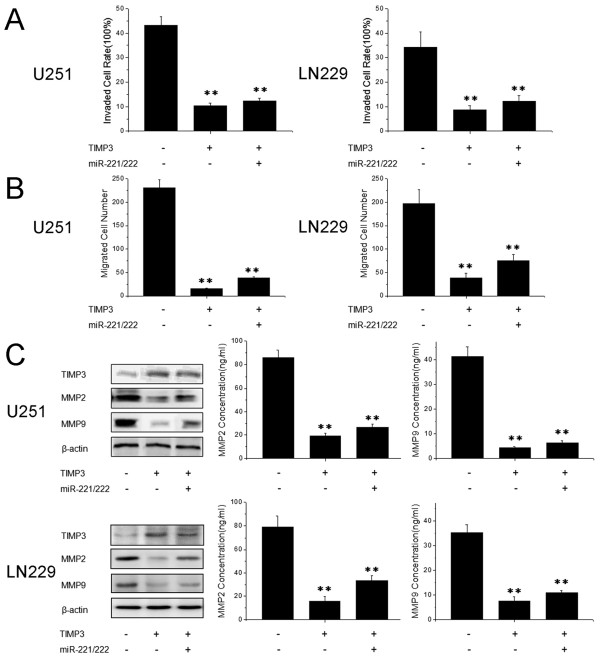
Expression of TIMP3 abrogates miR-221/222-mediated invasion.(A) and (B) Cells were transfected with pcDNA-TIMP3 and miR-221/222, and transwell assays (A) and wound healing assays (B) were performed. (C) Cells were transfected with pcDNA-TIMP3 lacking the 3’ UTR and miR-221/222 and TIMP3, MMP2 and MMP9 protein levels were detected by western blot assays. β-actin protein was assayed as a control. In addition, the levels of MMP2 and MMP9 were measured by ELISA assays. Error bars represent standard deviation and were obtained from three independent experiments. ** P <0.01 compared with control group.